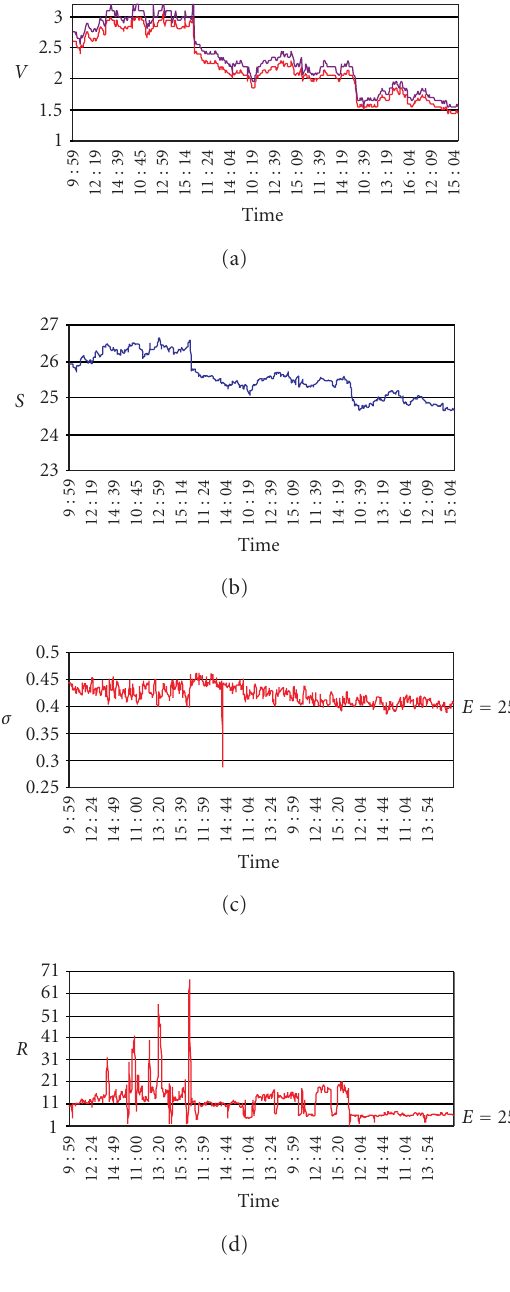
Figure 5.5. One week behavior of Microsoft stocks (March 20–27, 2003) and Call options with expi- ration date April 19, 2003. Computed implied volatilities σ RAPM and risk premiums R